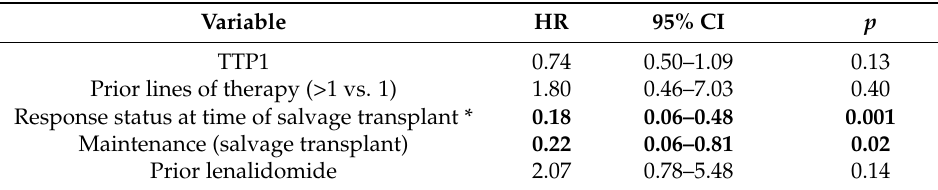
Table 3. Multivariate Cox regression analysis of prognostic impact on progression free survival (PFS) from salvage HDCT/ASCT.